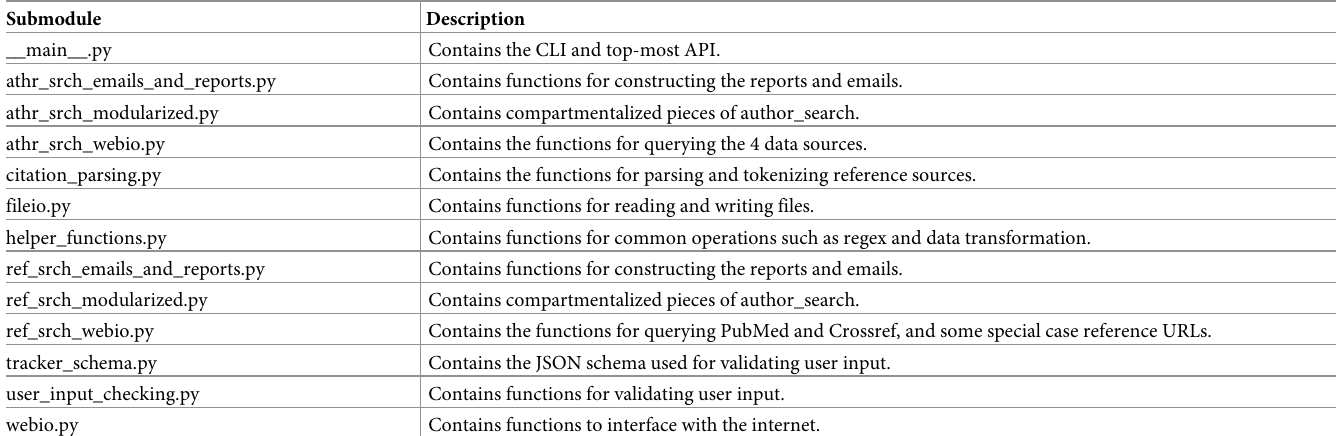
Table 4. Submodules of Academic Tracker.